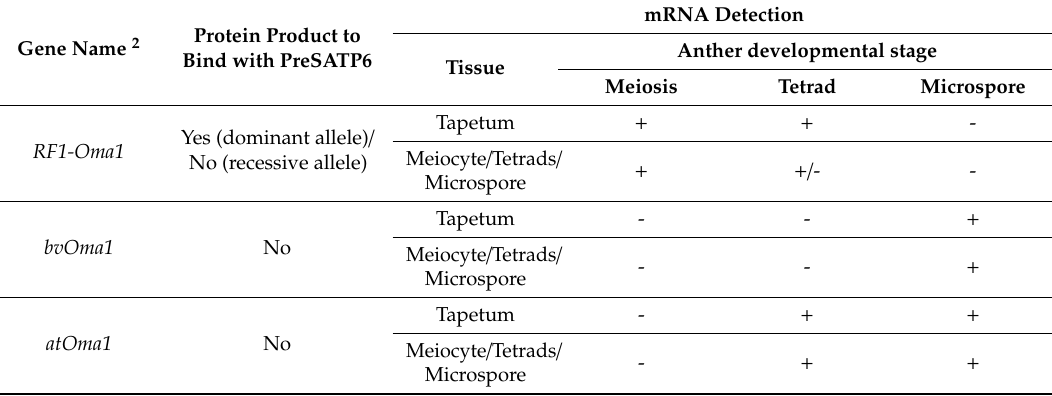
Table 2. Di ff erences in protein function and expression patterns of Oma1 homologues in sugar beet and Arabidopsis 1